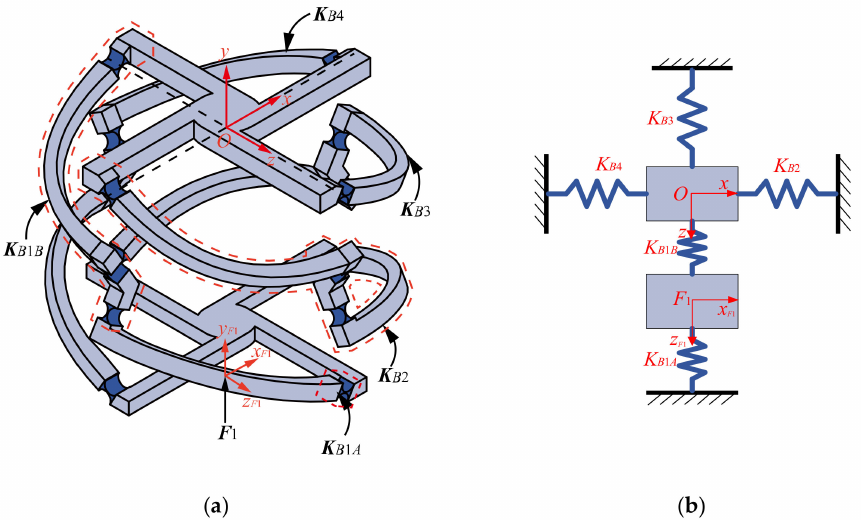
Figure 10. 4-4R compliant parallel pointing mechanism subjected to force F 1 : ( a ) Simplification of equivalent stiffness; ( b ) equivalent spring